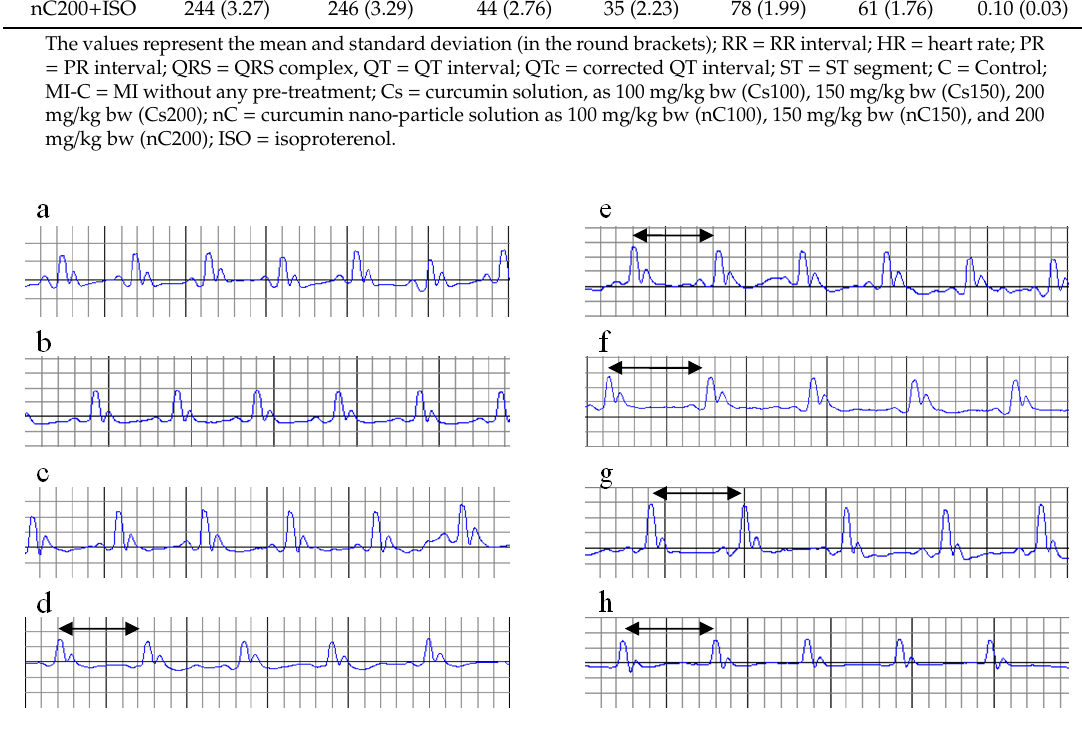
Figure 2. ECGs on day 12 (before ISO administration). Increased RR interval (black arrow). ( a ) C